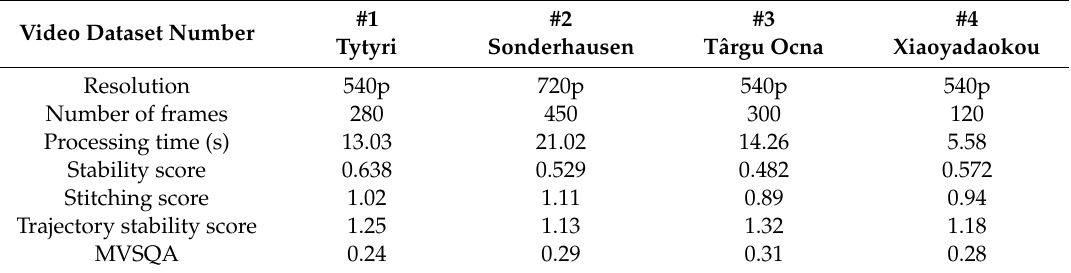
Table 2. Quantitative evaluation of stitching quality on four video